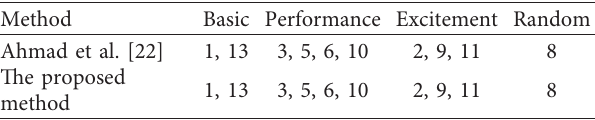
Table 7: Attributes with similar categories as defined by the method proposed by Ahmad et al. [22] and the proposed method. Ten attributes have similar categories.